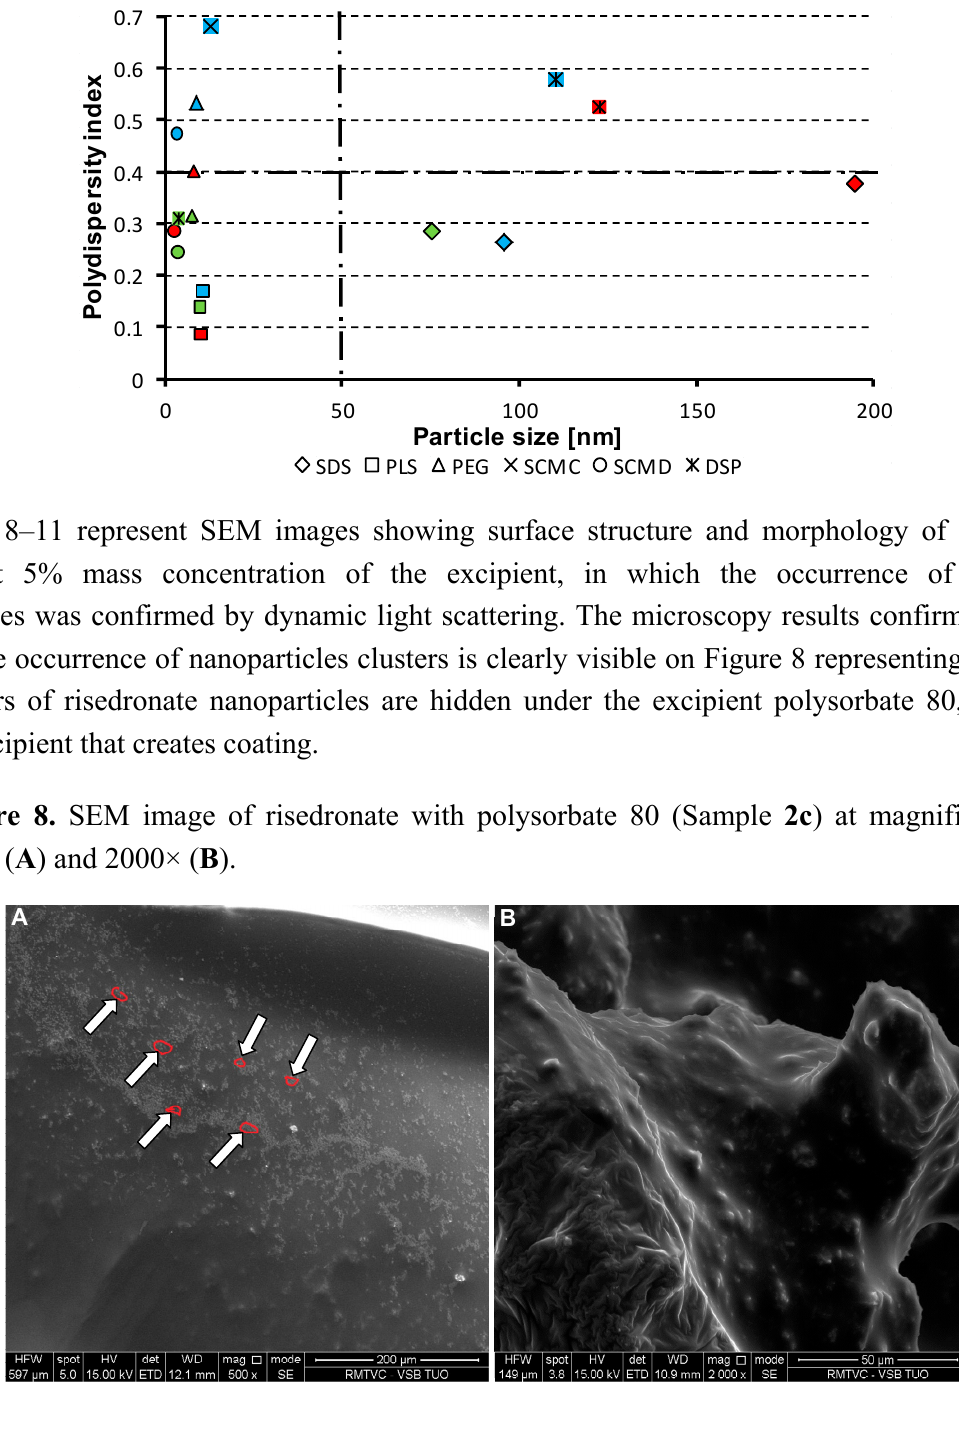
Figure 7. Relationships between polydispersity index values and particle size of risedronate sodium in relation to applied excipients. (SDS = sodium dodecyl sulfate, PLS = polysorbate 80, PEG = macrogol 6000, SCMC = sodium carboxymethyl cellulose, SCMD = sodium carboxymethyl dextran, DSP = sodium dodecyl sulfate/macrogol 6000; fill colour of individual symbols depends on concentration of excipient: 1% = blue, 3% = red, 5% = green).